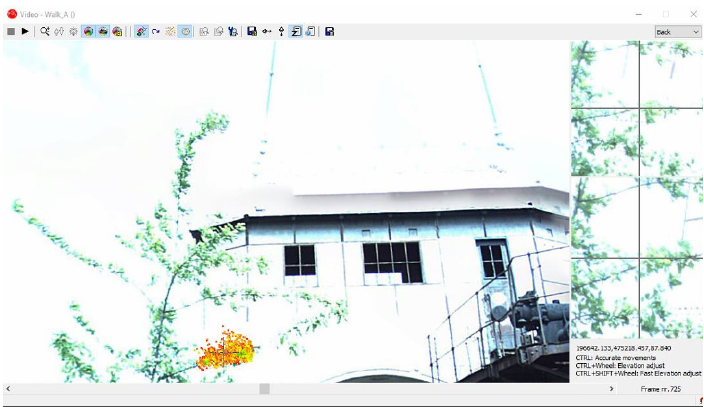
Figure 26. Real-time view of point clouds.